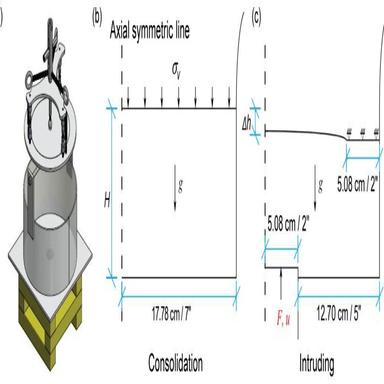
Geometry and boundary conditions of the axial shear test. (a) A schematic view of the test setup. (b) The boundary condition for the consolidation step. (c) The boundary condition for the piston intruder.